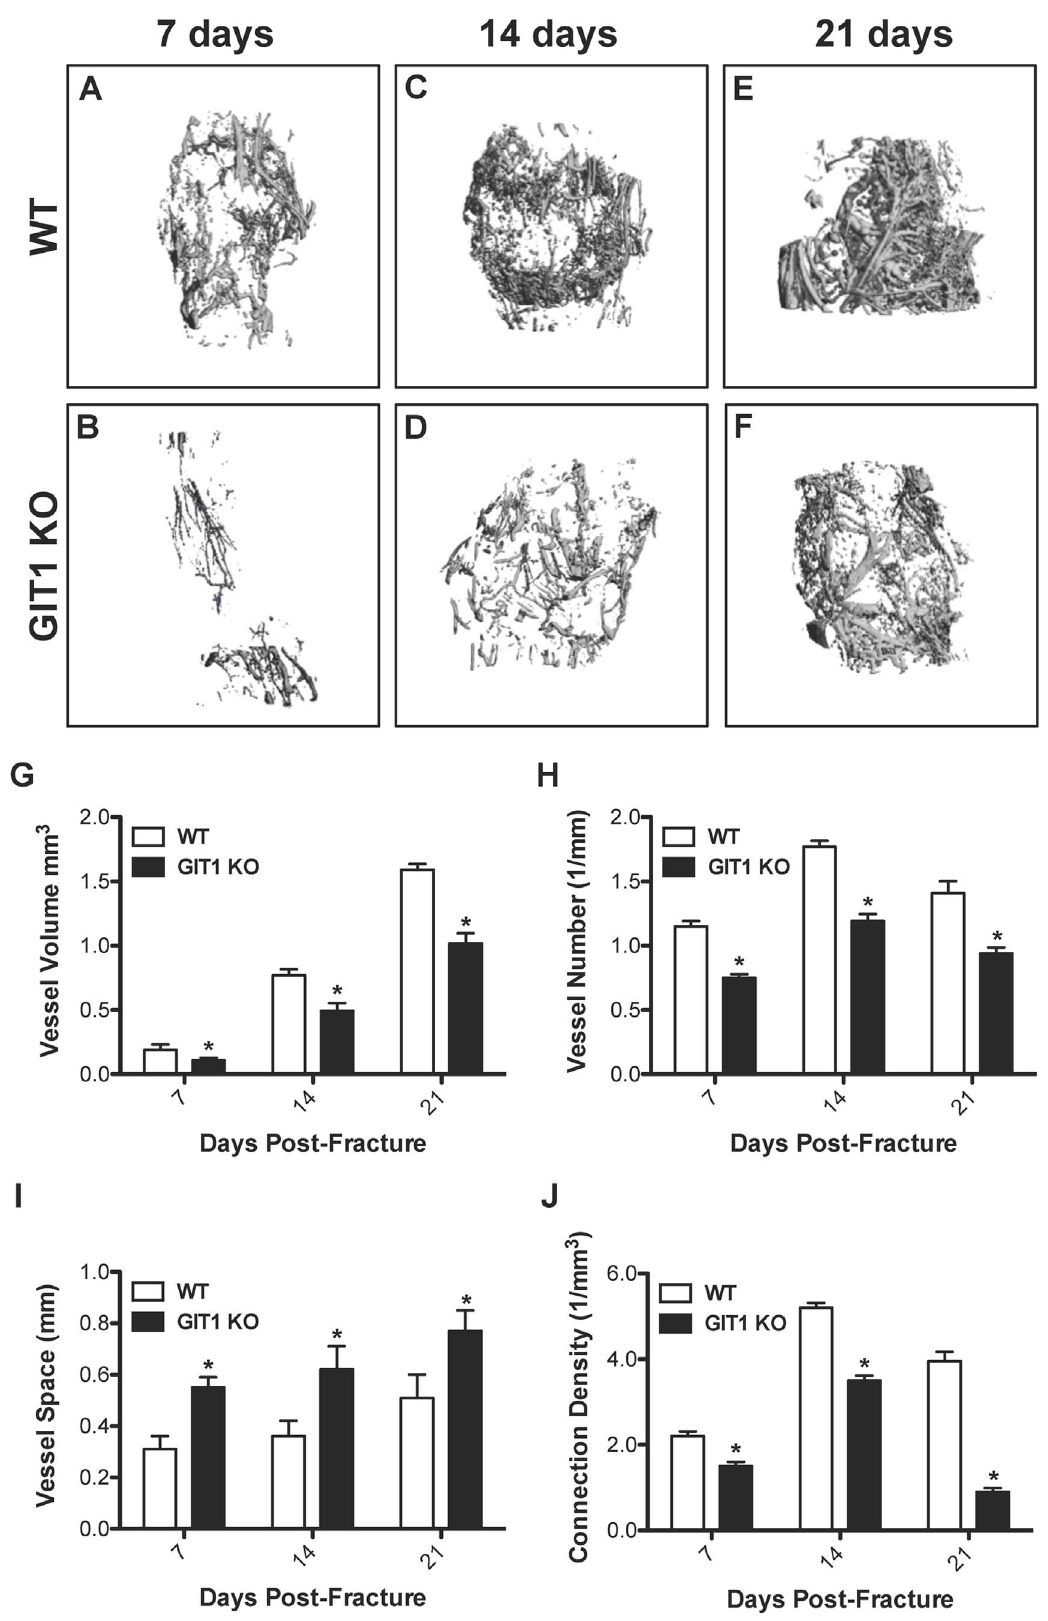
Figure 7. Fracture callus vascularity is reduced in GIT1 KO mice. To visualize and quantify callus vascularity, WT and GIT1 KO mice were perfused with lead chromate microfilm perfusion reagent. Harvested femora were decalcified and representative vascular microCT reconstructions